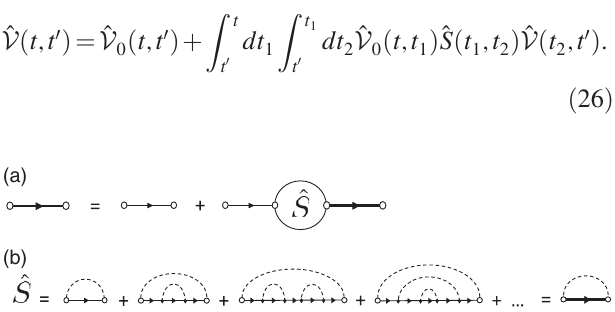
FIG. 4. (a) Diagrammatic representation of the Dyson series in Eq. (26). The bold (thin) solid lines represent the full, non- Markovian (bare, Markovian) impurity superoperator while the dashed lines correspond to the non-Markovian bath Δ . (b) Expression of the self-energy diagrams with noncrossing Δ lines are retained whose sum can be explicitly evaluated; see Eq.